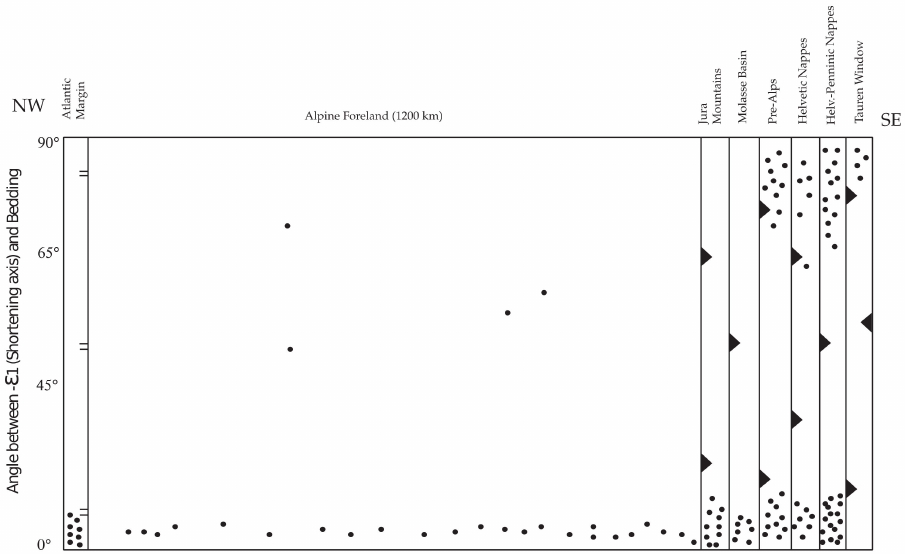
Figure 10. Plot of the angle between the calcite twining shortening axis and bedding for the Alps, Alpine foreland and the older (58 Ma) divergent Atlantic margin in